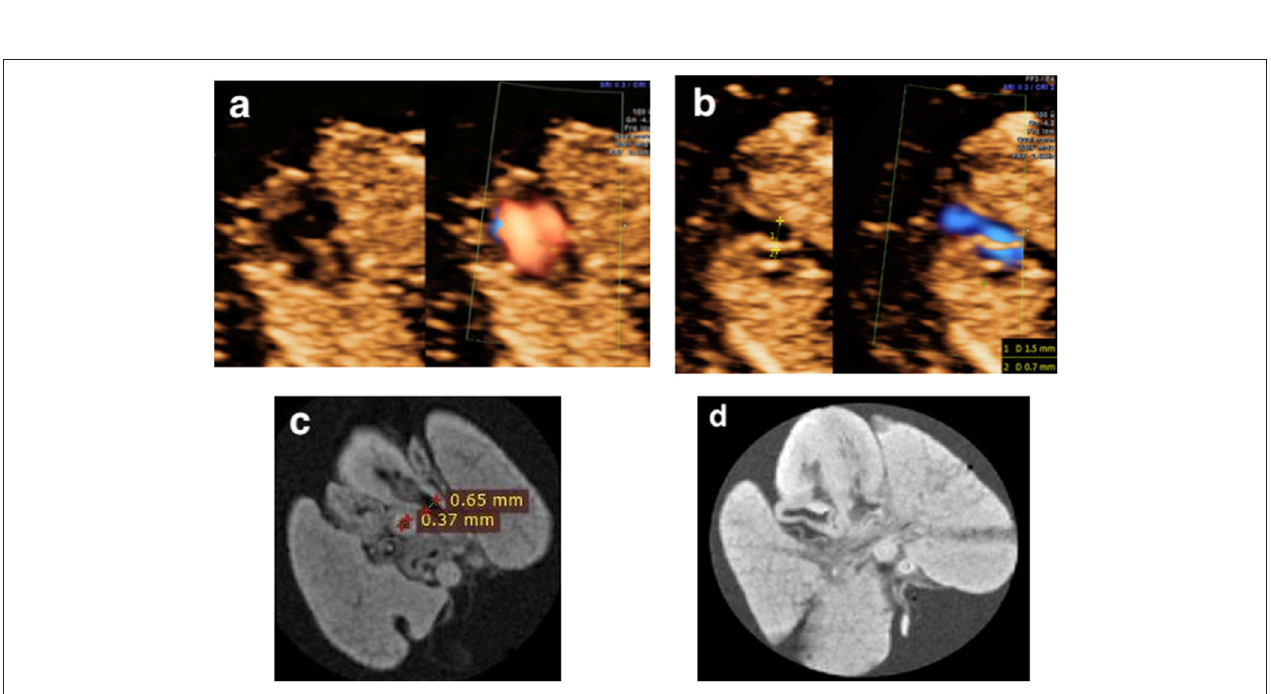
FIGURE 8 | (a,b) A fetus presented with a smaller left ventricle on the four-chamber view and a larger pulmonary artery diameter than that of the aorta (1.5 vs. 0.7mm) at the three-vessel view in the first trimester and was terminated at 12 + 6 weeks of gestation for Turner syndrome (Case 12 in Table 2 ). (c,d) Postmortem MRI showed a normally connected heart with the crossing of the great vessels and a larger pulmonary artery diameter than that of the aorta (0.65 vs. 0.37mm).